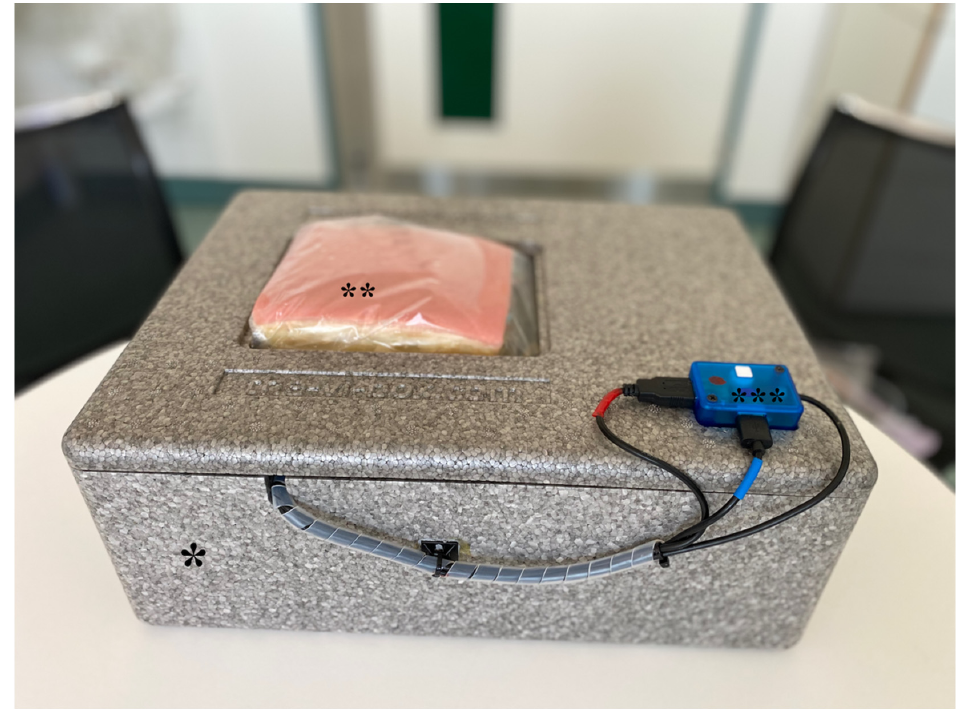
Figure 2. Complete pAVF simulation model. Legend: simulation model box * with hydrogel inlay ** and pump